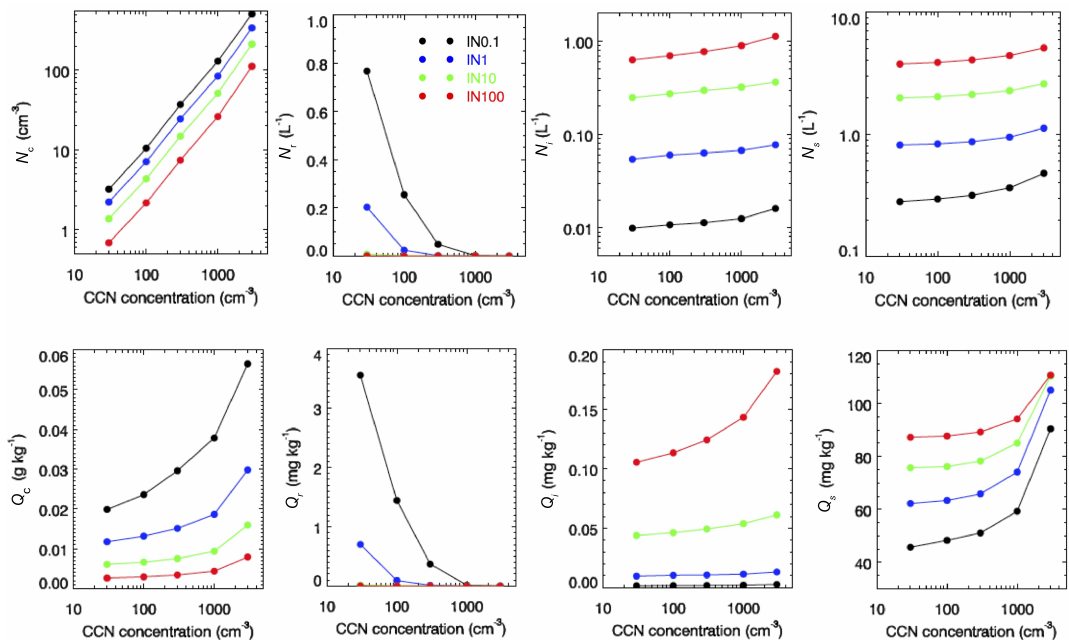
Figure 3. The number concentrations (top row) and mass mixing ratios (bottom row) of droplets (first column), rain (second column), cloud ice (third column), and snow (fourth column) for the CMOC. The data are averaged over the grid points over the domain by excluding the lateral boundary grid points below the 7km altitude and over the simulation time by excluding the first